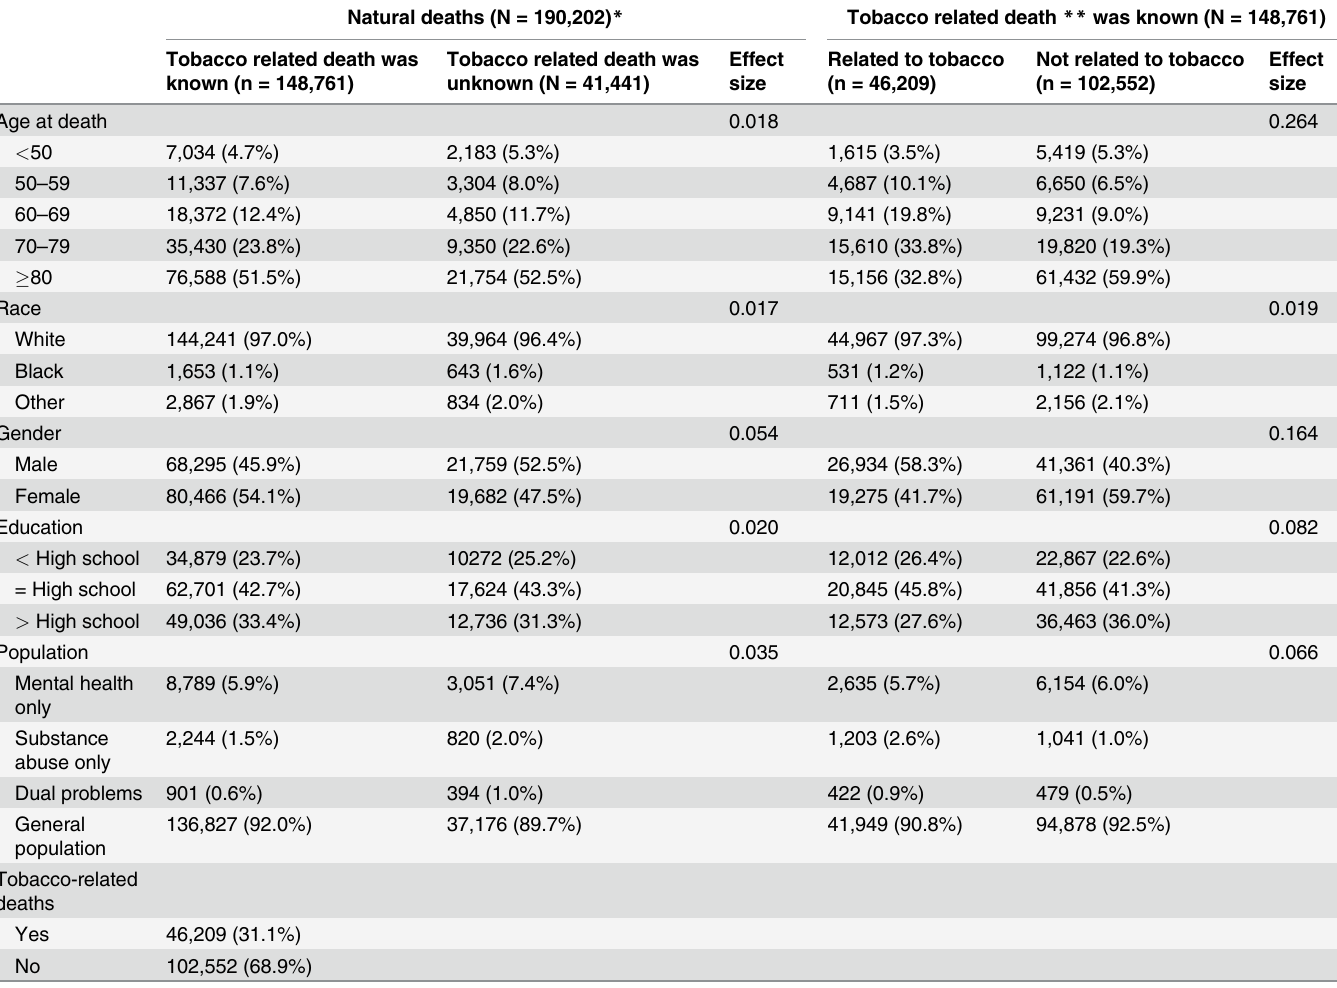
Table 1. Demographic characteristics for cases with natural deaths occurring in Oregon State, 1999 –